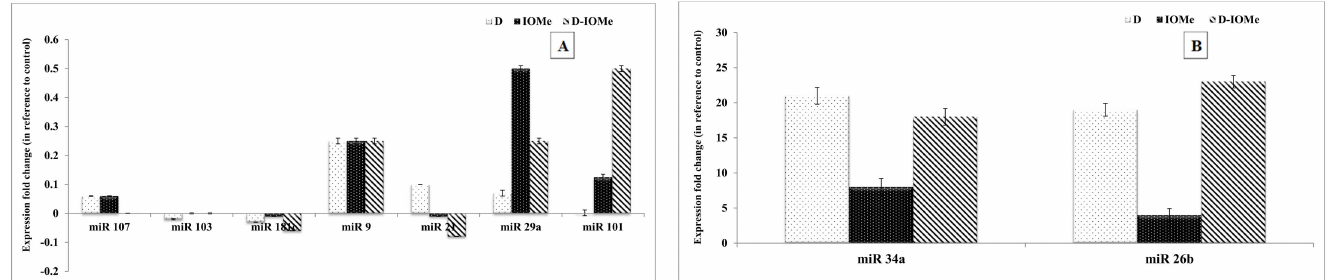
Fig 5. Decreased miRNA expression levels in the blood serum of HFD/STZ-induced rats. The expressionlevels of miRNAs miR-107, miR-181c, miR-103, miR-101, miR-29a,miR-21 and miR-9 expressionlevels were down-regulated in the serum of diabeticrats and IOMe-injected rats (A). The expressionlevels of miRNAs miR-34aand miR-26bwere up-regulated in serum of diabetic and in IOMe-AG538-injectedrats